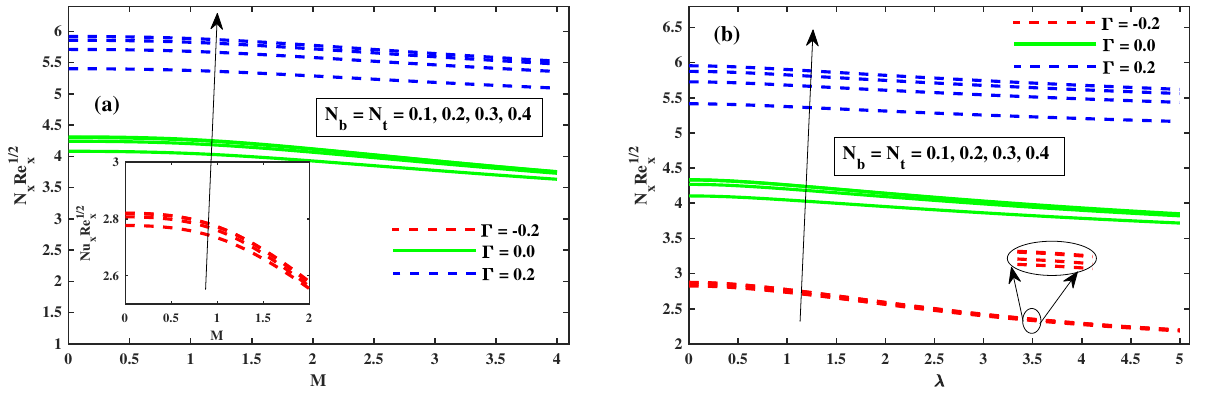
Figure 17. Fluctuation in N x Re 1 x /2 for N b , N t , along M in ( a ) and along λ in ( b